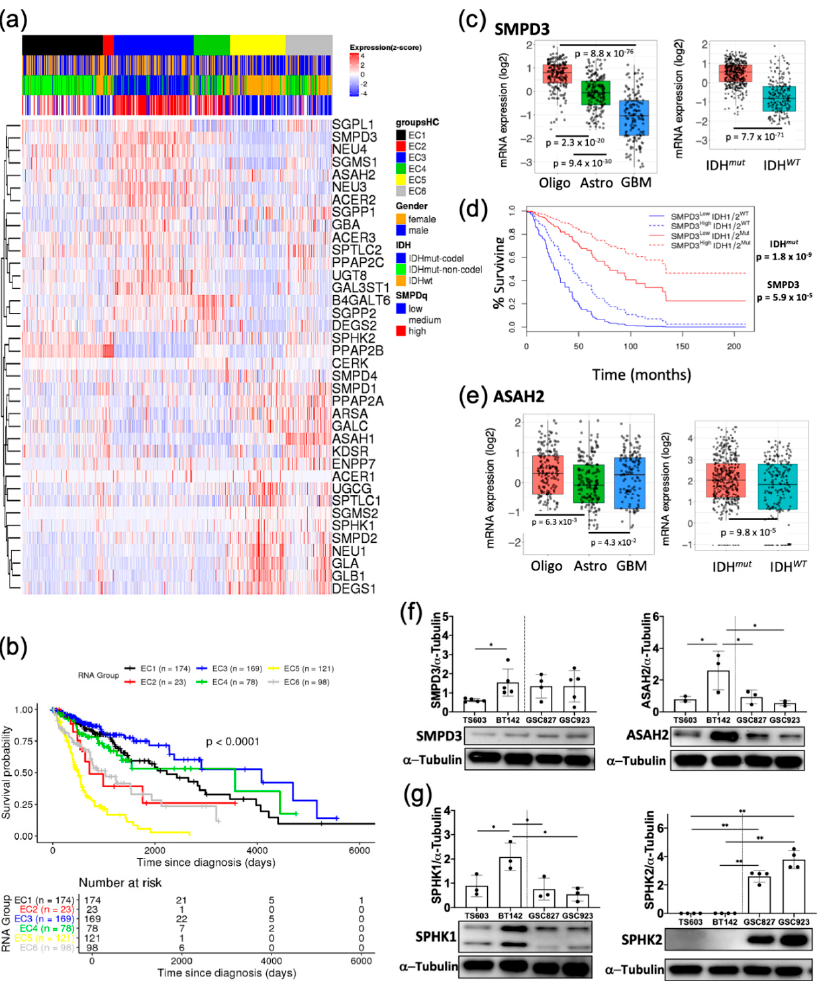
Figure 3. TCGA and Western blot analysis revealed proteins in sphingolipid pathway upregulated in IDH mut glioma and correlated with increased survival. ( a ) Consensus clustering of genes from sphingolipid pathway using the mRNA levels from the TCGA cohort. The heatmap illustrates gene expression profiles as clustered by the consensus algorithm using clinical patient data showing 6 major expression clusters: EC1 (black), EC2 (red), EC3 (blue), EC4 (green), EC5 (yellow) and EC6 (grey) as indicated. Cluster labeled EC1 is mainly composed of IDH mutant astrocytoma (green outline); EC3 is mainly composed of the IDH mutant with codeletion of chromosomes 1p / 19q (oligodendrogliomas) (blue outline); EC5 is predominantly composed of the heterogenous group representing a high influence of IDH WT samples. In the second row, below the EC groups, the gender is represented as female (orange) and male (blue). The third raw histological group is represented as IDH mut non-codel (astrocytoma, green), IDH mut 1p / 19q codeleted (oligodendroglioma, blue) and IDH WT (mostly glioblastomas, orange). The last raw depicts the average expression of SMPD2 and SMPD3. ( b ) Kaplan Meier overall survival analysis was applied unsupervised to assess the di ff erences in survival based on primary gene expression among the cohorts as determined by the clustering analysis, and overall Log rank test p -value was found to be < 0.0001. ( c ) mRNA levels of SMPD3 across the TCGA histological groups and as a function of IDH mutation. ( d ) Kaplan Meier overall survival analysis of patients with high expression of SMPD3 and presence or absence of IDH mutation. ( e ) mRNA levels of ASAH2 across the TCGA histological groups and as a function of IDH mutation. ( f ) Western blot analysis of SMPD3 and ASAH2 in IDH mut and IDH WT cell lines. ( g ) Western blot analysis of SPHK1 and SPHK2 in IDH mut and IDH WT cell lines. Figure S3: Full WB blot images from Figure 3f,g. Gels were quantified using Image J. T-tests were run in Prism 8.2.1. p -values are represented as follows: ** p < 0.005; * p < 0.05; ns, not significant comparisons were not shown for